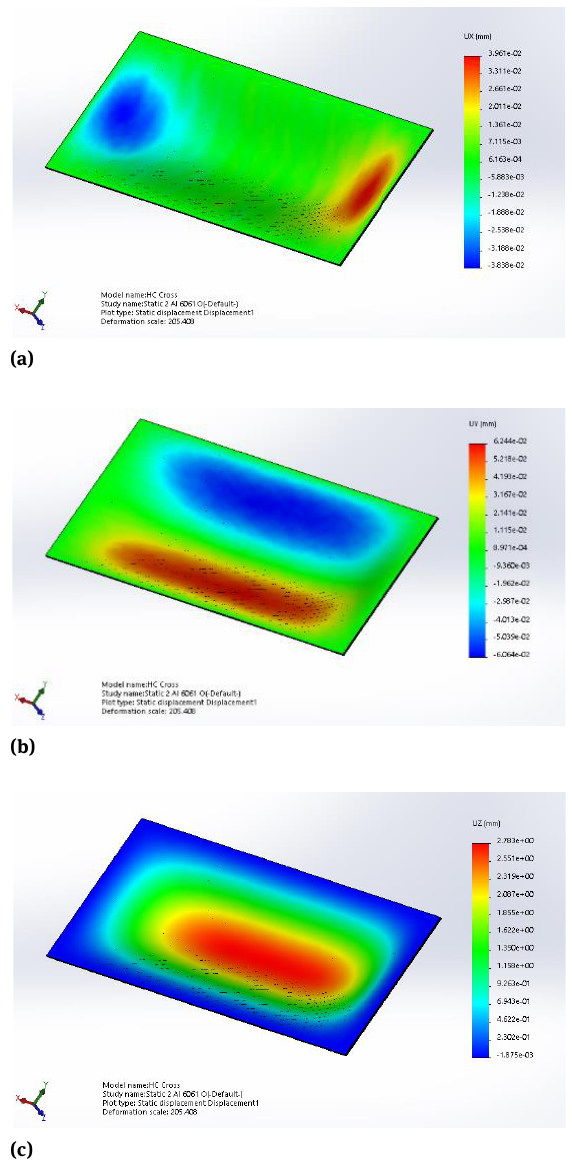
Figure 13: Results for the cross honeycomb: (a) Von Mises stress and (b) resultant displacement